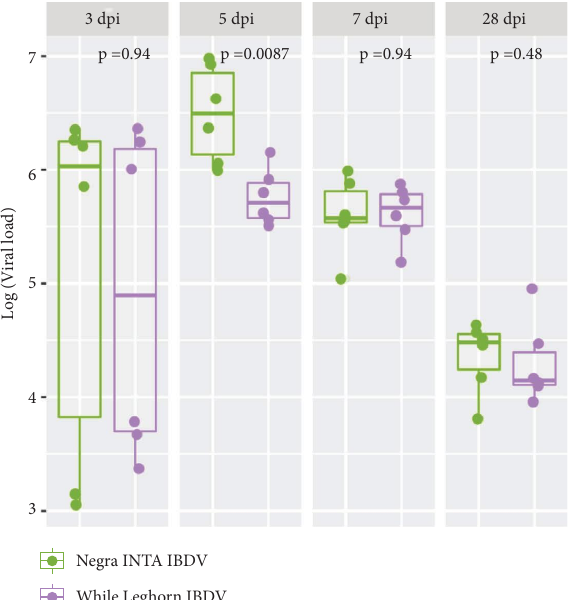
Figure 5: Viral load in the bursa of IBDV-infected chickens. Bursae were collected at 3, 5, 7, and 28dpi and total RNA was extracted. Te number of IBDV viral copies/ μ g of bursal RNA was estimated by RT-qPCR. Te log of individual values (dots) as well as box plots representing data distribution are shown for each group. Te p value is shown for each day ( t -test).